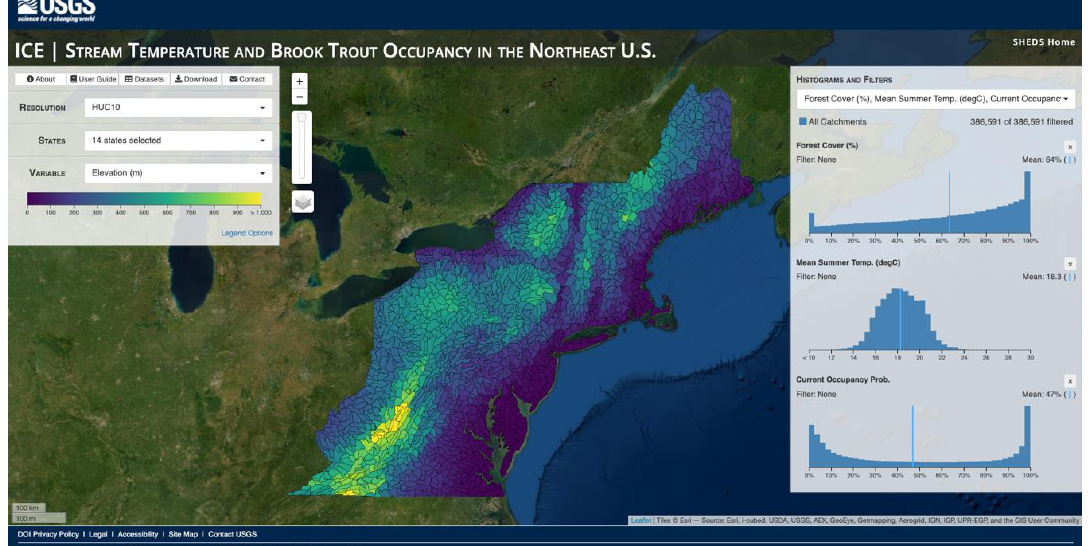
Figure 6. Screenshot of the ICE Web application for stream temperature and brook trout occupancy in the northeast region showing the area-weighted mean elevation of each HUC10 basin and crossfilters for catchments’ percentage of forest cover, mean summer stream temperature and the probability of brook trout occupancy under current climate conditions. Available at https://www.usgs.gov/apps/ecosheds/ice-northeast.